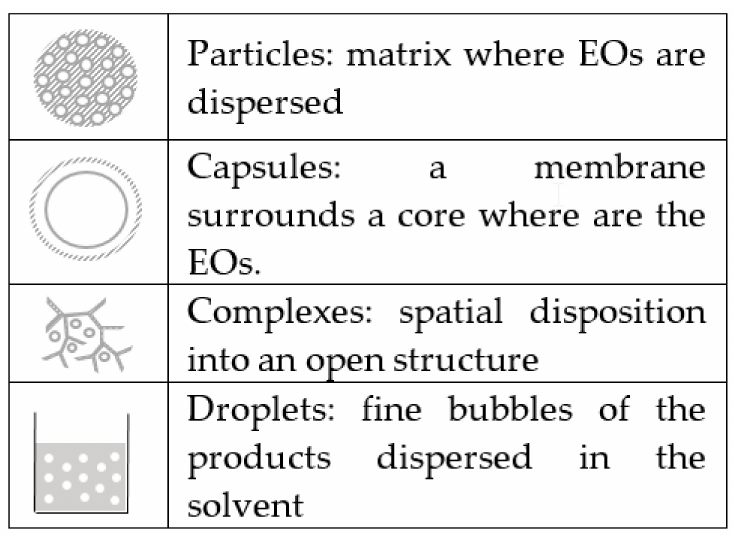
Figure 2. Illustration of essential oil (EO) encapsulation